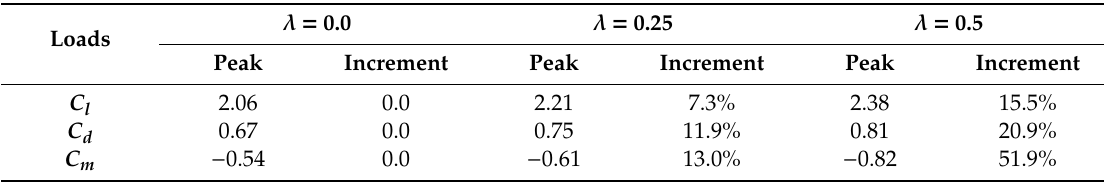
Table 3. Peaks of the aerodynamic loads.